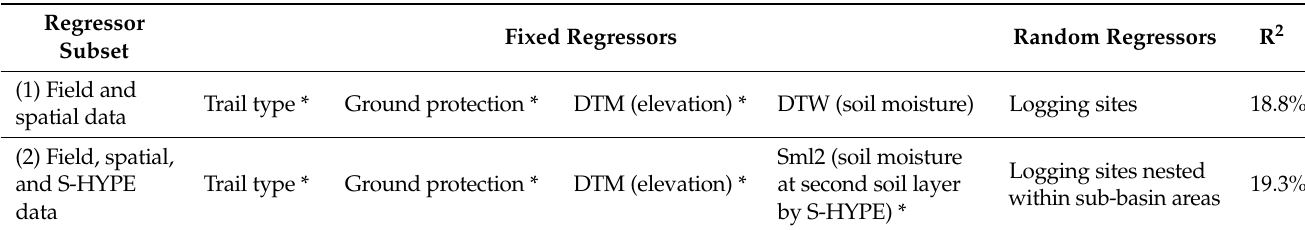
Table 2. Description of regressor subsets and models efficiency, R 2 , for inferring variation of rut depth within logging sites. Regressors marked with (*) were identified as significant at p < 0.05